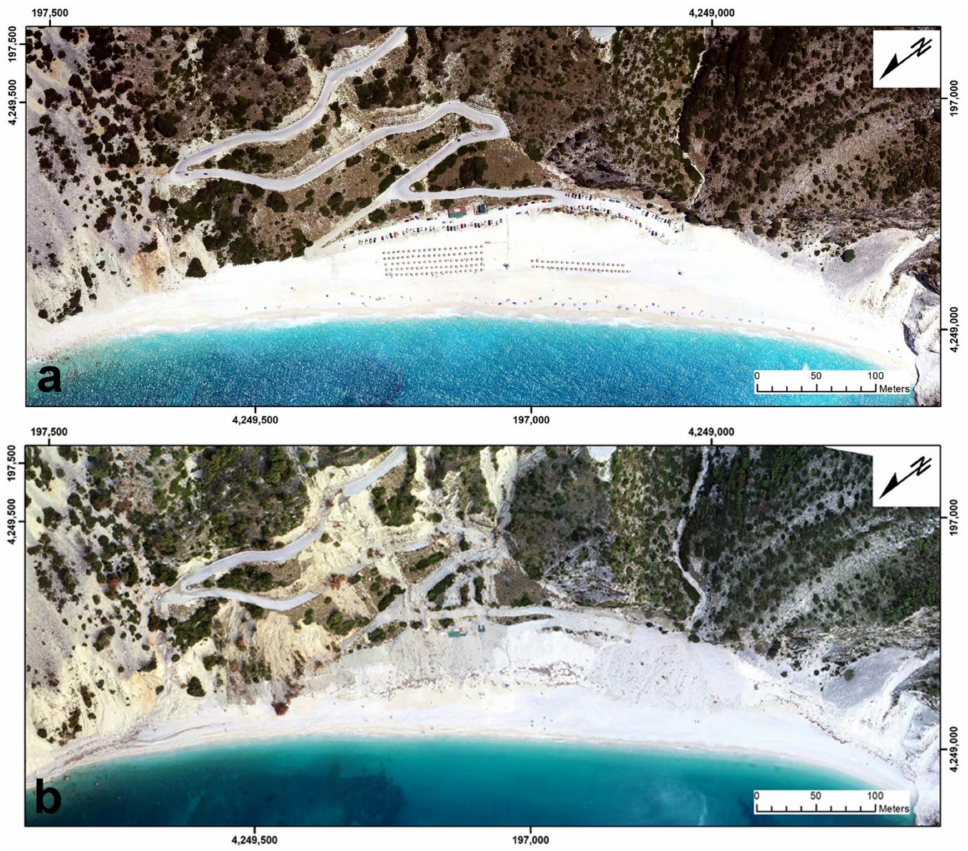
Figure 8. Overview of the geomorphic changes at the popular Myrtos beach, through comparison of the constructed orthoimages before ( a ) and after ( b ) the Medicane Ianos disaster. Table 1. Details of the photogrammetric processing of the two